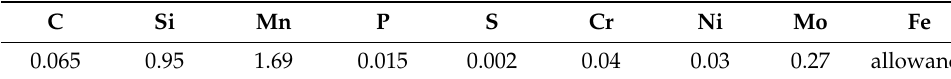
Table 2. Chemical composition of X100 pipeline steel (%).